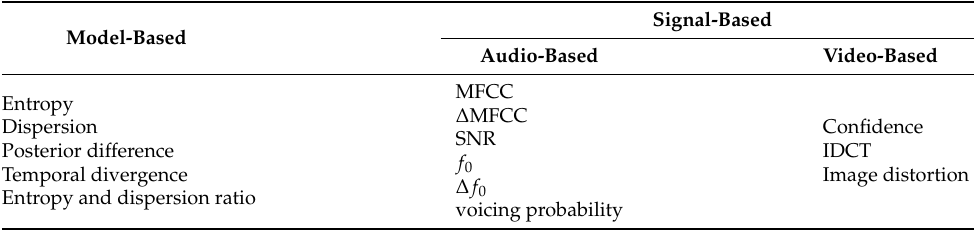
Table 1. Overview of reliability